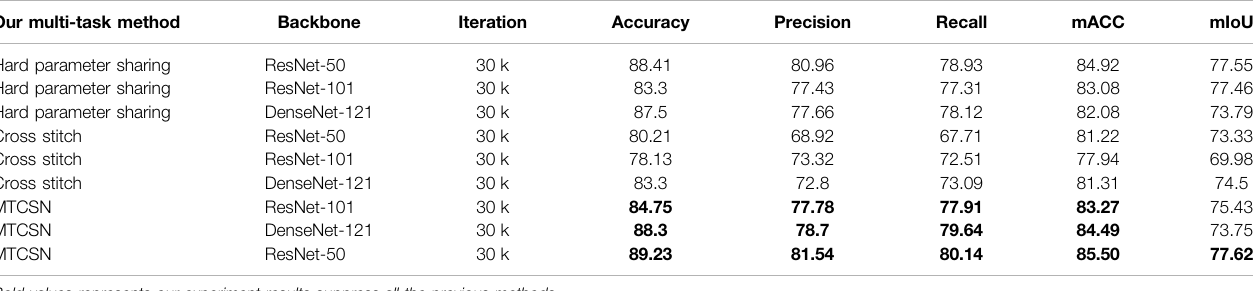
TABLE 5 | Detailed analysis of our proposed MTCSN in comparison with others. Our multi-task method